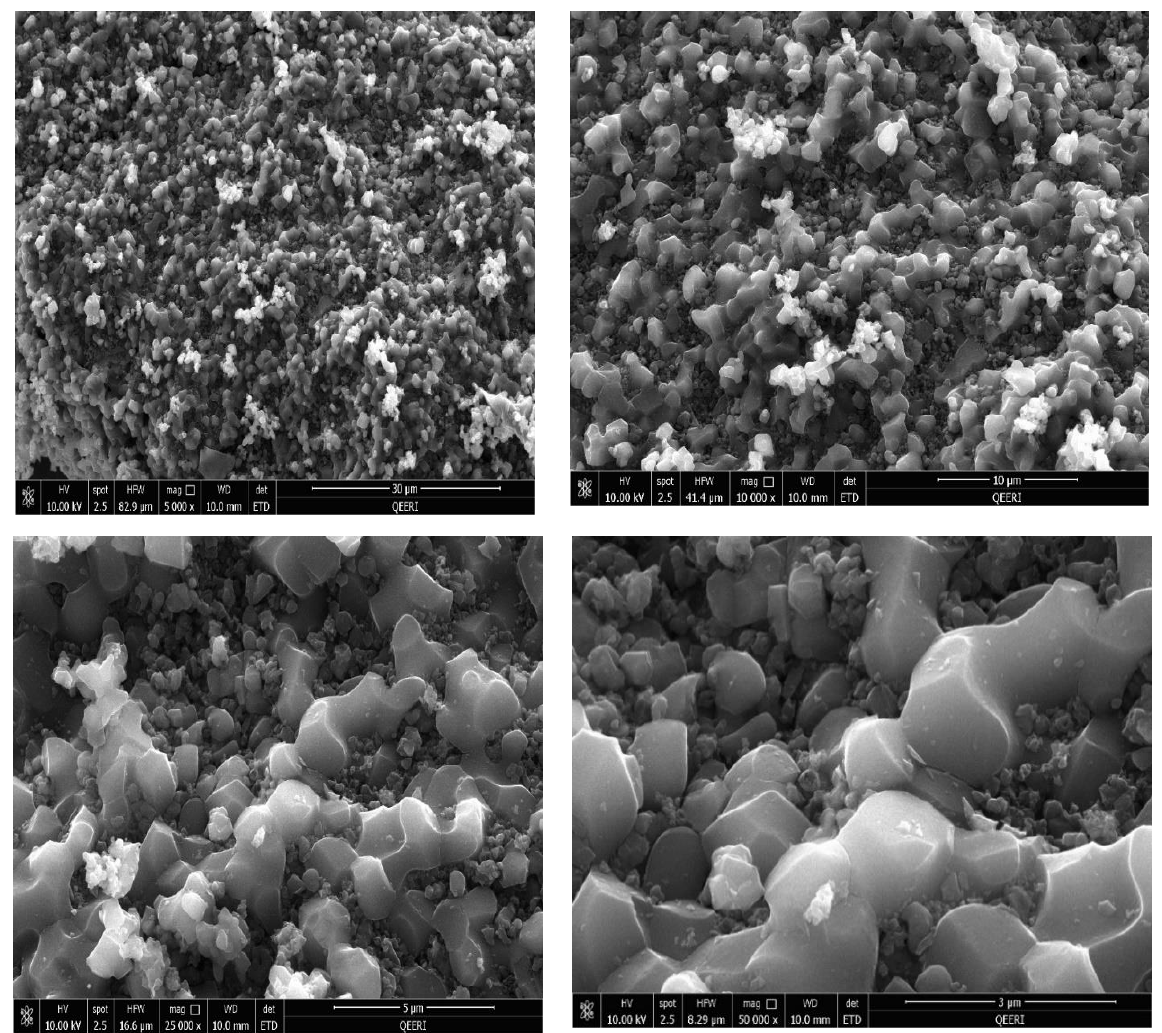
Figure 2. SEM images of CDC particles at different magnifications.